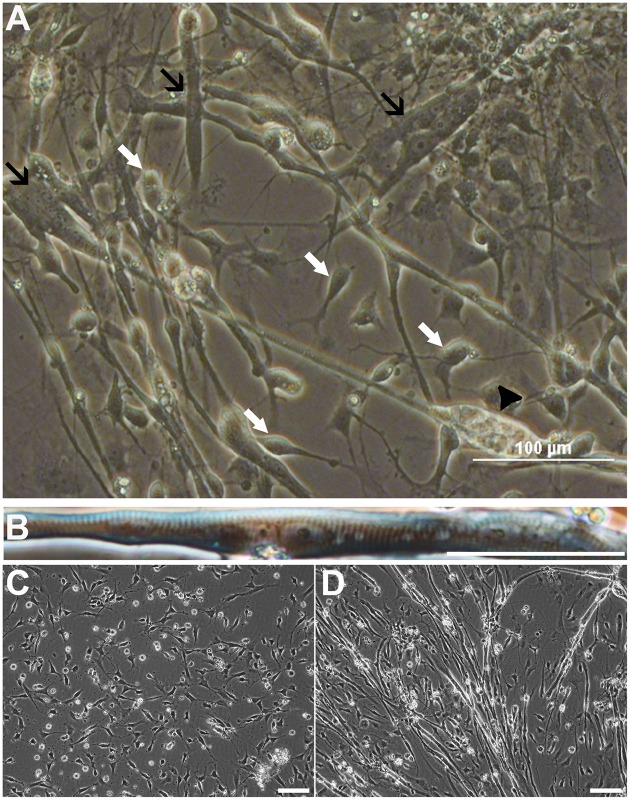
Cells from non-selected spheres mature into neurons and myotubes derived from ESCs (HS306). Cell populations contain neural progenitors and mature neurons with neurites (A, white arrows), and non-striated (A, black arrows) and striated (B) multinucleated myotubes. In these cultures, myotubes are spontaneously contracting (A, Video S1). Eventually, the contraction and movement may lead to the detachment and further degeneration of the myotube (A, black arrowhead). Time-lapse imaging of the same view reveals that myoprecursors and myotubes are highly mobile, and the fusion of precursor cells into myotubes is a dynamic process (C,D, Video S2). Scale bars: (A) 100 μm; (B) 50 μm; (C,D) 100 μm.